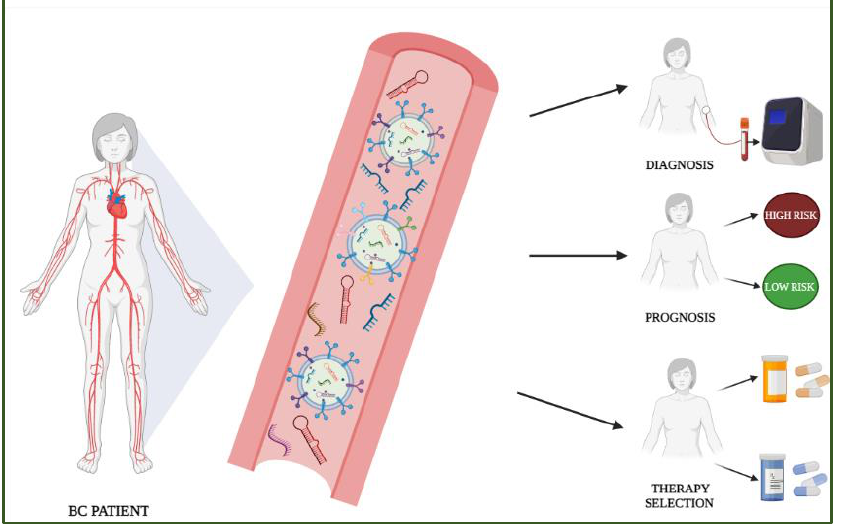
Figure 1. Schematic representation of the possible applications of miRNAs for BC patient management.